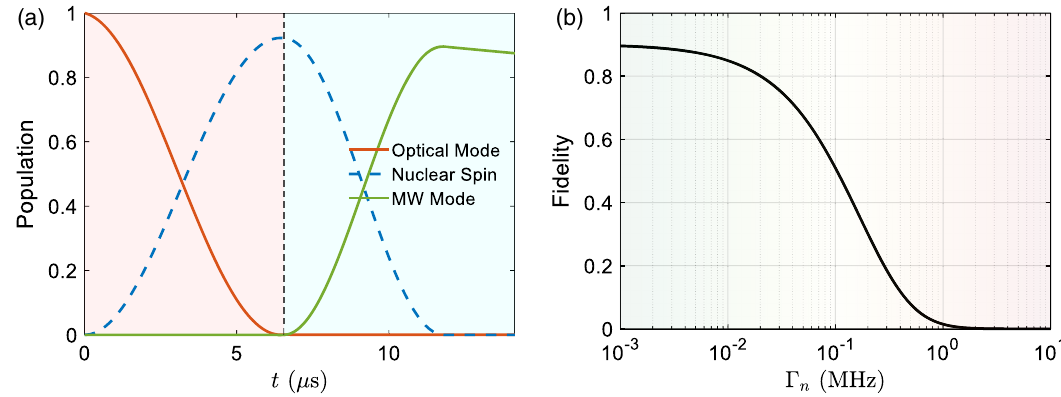
FIG. 3. Simulation results of optical to MW or rf transduction. (a) Population of different subsystems as a function of time t . Here, we ¼ 1 kHz. In the light-red shaded region, the optical-nuclear interaction is turned on, while in the light-blue shaded region, the take Γ n MW-nuclear interaction is turned on. (b) Fidelity of the optical to MW transition as a function of NSE relaxation rate Γ ≈ 0 . 24 MHz and G ∼ 0 . 3 simulations, we take G o m